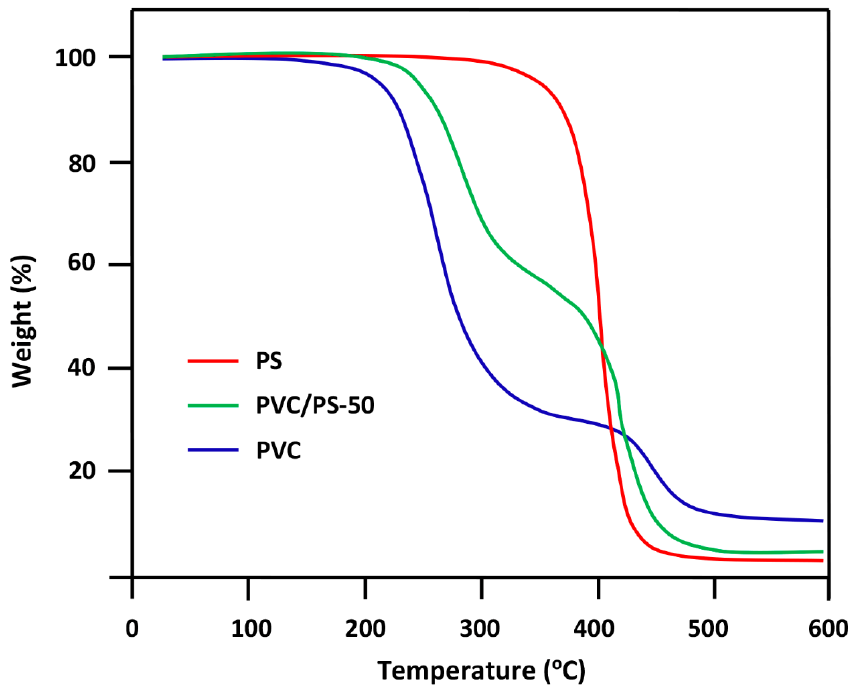
Figure 7. TGA thermograms of PVC/PS-50 blend and their pure components PVC and PS.